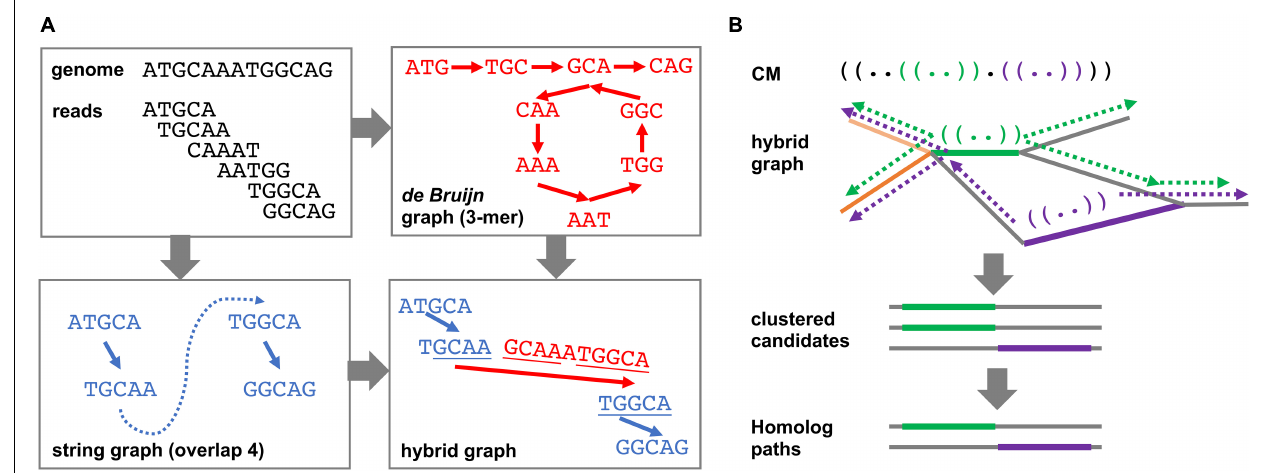
FIGURE 1 | Schematic illustration of the DRAGoM algorithm. (A) The construction of the hybrid assembly graph. The hybrid graph, resulting from the merging of a de Bruijn graph and a string graph, can perfectly represent the original genome used in this toy example. (B) The search of ncRNA homologs against a hybrid graph. The green and purple parentheses in the querying ncRNACM (covariant model) represent local secondary structural components. The thick green and purple lines in the hybrid graph indicate anchors for path extension. Arrows indicate path extensions of the corresponding